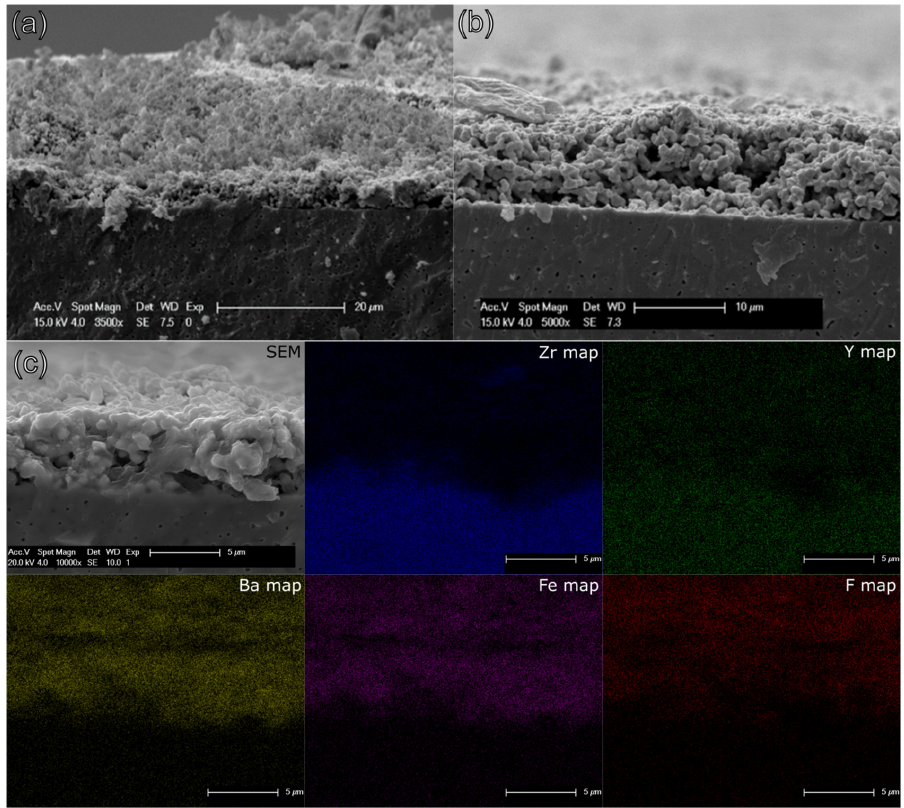
Figure 11. SEM before ( a ) and after ( b ) sintering. EDX ( c ) of a topochemically fluorinated BFOF film, mapping the main elements of the used materials: Zr, Y, Ba, Fe, F. Table 1. Lattice parameters and cell volume per formula unit Z of BaFeX y (X = O, F) for the sintered and topochemically modified films.